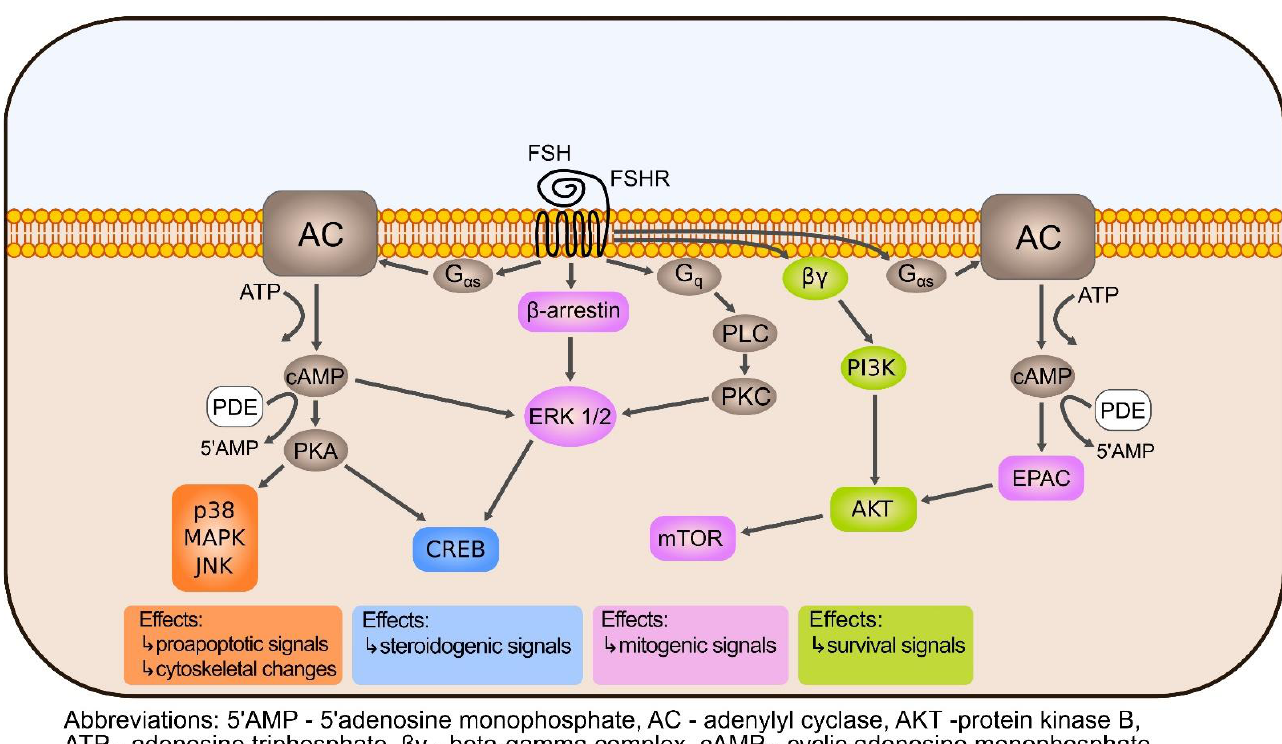
Figure 1. FSH signaling. In response to FSH binding to its specific receptor (FSHR), the corresponding G protein and β - arrestin subunits are activated. Gαs protein -associated signaling stimulates membrane adenylate cyclase (AC) to synthesize cAMP from ATP. PDE opposes the effects of adenylate cyclase by hydrolyzing cAMP. Elevated cAMP activates protein kinase A (PKA), thereby inducing pro-apoptotic signals and cytoskeleton changes (effects related to p38, MAPK, and JNK). cAMP/PKA/CREB activates steroidogenic signals. Epac, as an intracellular cAMP receptor, activates processes related to mitogenic signals (via mTOR) or survival signals (via AKT, the activity of which is also regulated by PI3K). FSH also activates the phospholipase C (PLC) and protein kinase C (PLC/PKC) pathways, which act on ERK1/ERK1/2 may also stimulate CREB. FSH-stimulated PKA activation is likely to result in the regulation of ovarian granu- losa cell (GC) metabolism and proliferation, and the production of sex steroids, while LH- induced cAMP/PKA is essential for GC differentiation and the synthesis of steroids re- quired for ovulation [81]. In immature granulosa cells, FSH signals via activation of phos- phoinositide-3-kinase – protein kinase B/Akt (PI3K-PKB/Akt) pathway, which is largely mediated by PKA. Activation of PKB (also known as Akt) is associated with increased proliferation, translation, and activation of target genes. During the early follicular phase of the ovarian cycle, relatively high levels of FSH protect granulosa cells of small imma- ture follicles from apoptosis [22]. The FSH-activated cAMP/PKA signaling induces ovar- ian steroid p roduction and granulosa cell differentiation. The Gαs/cAMP/protein kinase A (PKA) is not the only transduction mechanism triggered by FSHR. FSH also engages the activation of the ERK1/2, which is essential for modulating both proliferation of gran- ulosa cells and steroidogenesis [82]. The actions of PKA are also confirmed in the nucleus indicating the potential involvement of PKA in chromatin remodeling through post-trans- lational modifications of histone H3 and participation in gene transcription. Translocation of the PKA C subunit into the nucleus leads to CREB phosphorylation, which possibly